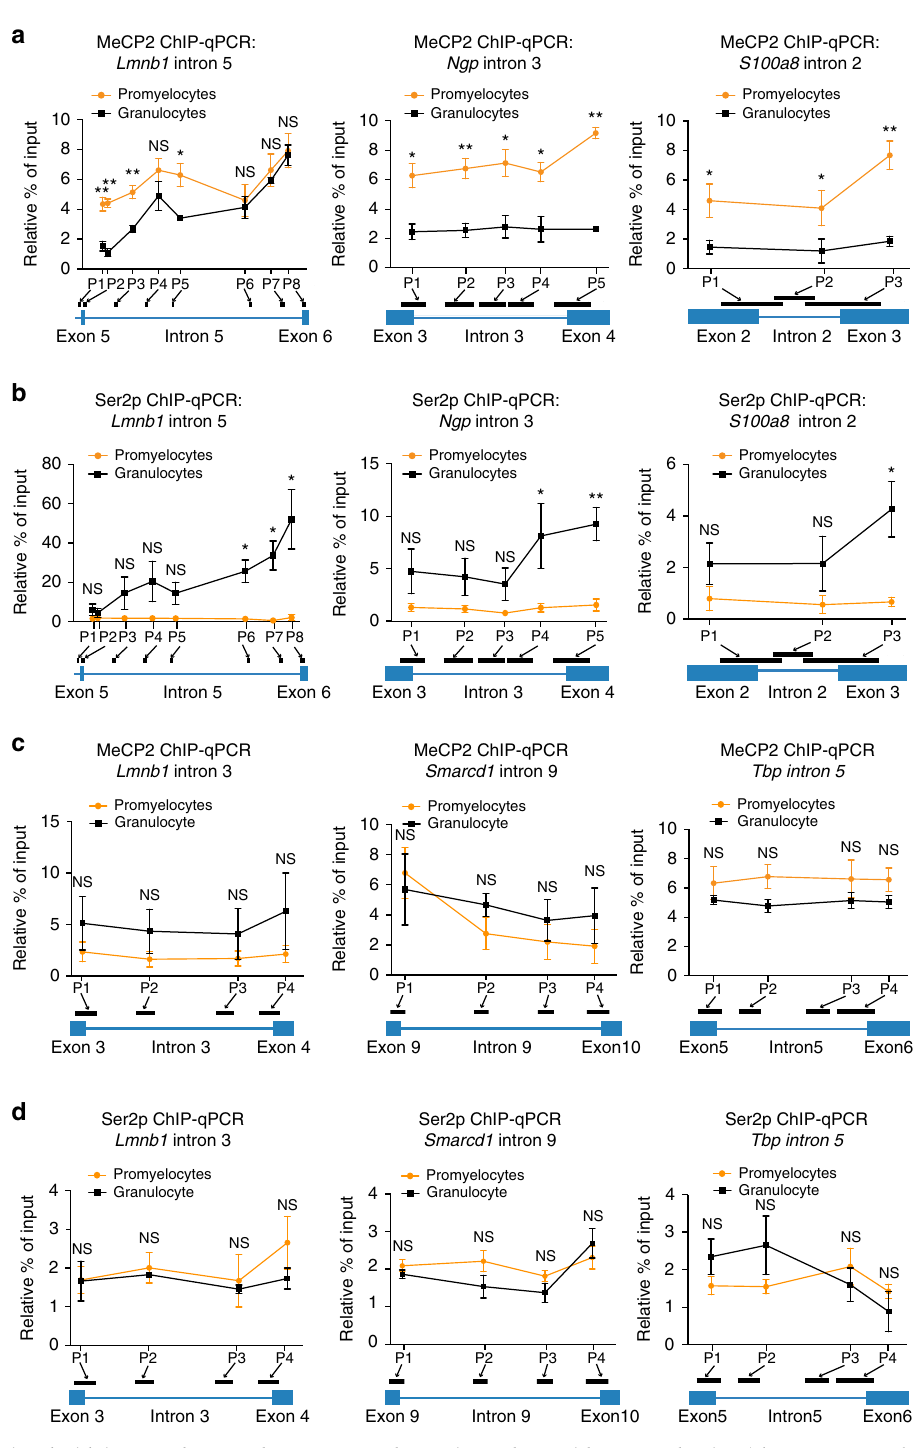
Figure 4 | IR is associated with increased RNA Pol II occupancy that anti-correlates with MeCP2 density. ( a ) Occupancies of MeCP2 and ( b ) Pol II Ser2p measured by ChIP-qPCR for retained introns and their flanking exons of Lmnb1 , Ngp and S100a8 in promyelocytes and granulocytes. ( c ) ChIP-qPCR analyses of MeCP2 and ( d ) Pol II Ser2p occupancies measured for non-retained introns: Lmnb1 intron 3, Smarcd1 intron 9, Tbp intron 5 and their flanking exons. P1–P8 indicate positions of PCR amplicons within each region. For each ChIP-qPCR experiment, a two-tailed Student’s t -test was used to determine significance, denoted by * P o 0.05, ** P o 0.001 and NS, not significant. Dots and bars display mean ± s.e.m. Independent ChIP-qPCR experiments were performed three to five times in